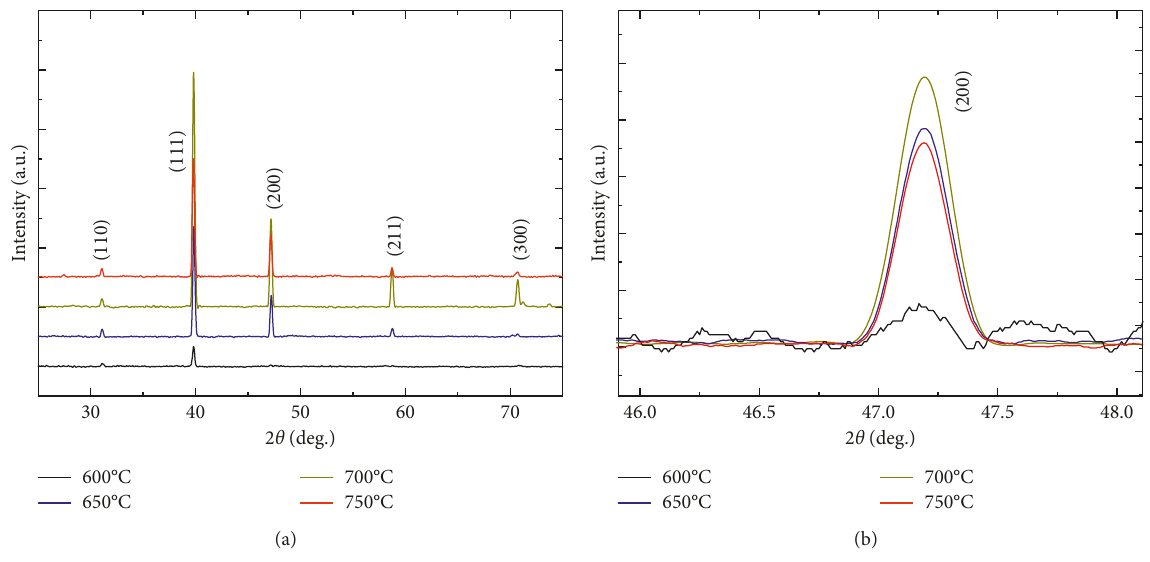
Figure 2: X-ray diffraction patterns of BNKT films in the 2 θ ranges of (a) 25 ° –75 ° and (b) 46–48 °